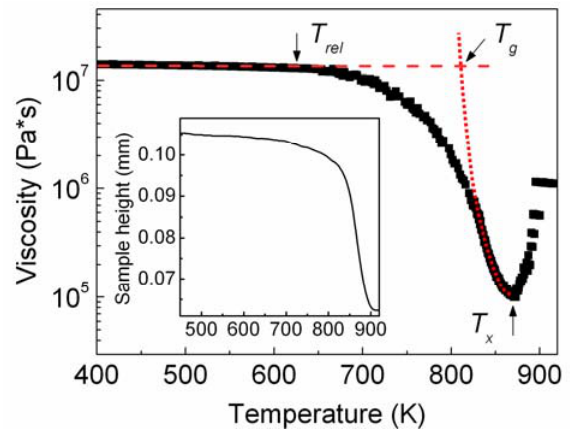
Figure 2. Temperature dependence (heating rate 30 K/min) of the viscosity of the supercooled liquid for the as-atomized Ni TMA measurement consisting of the change of the height of the sample as a function of